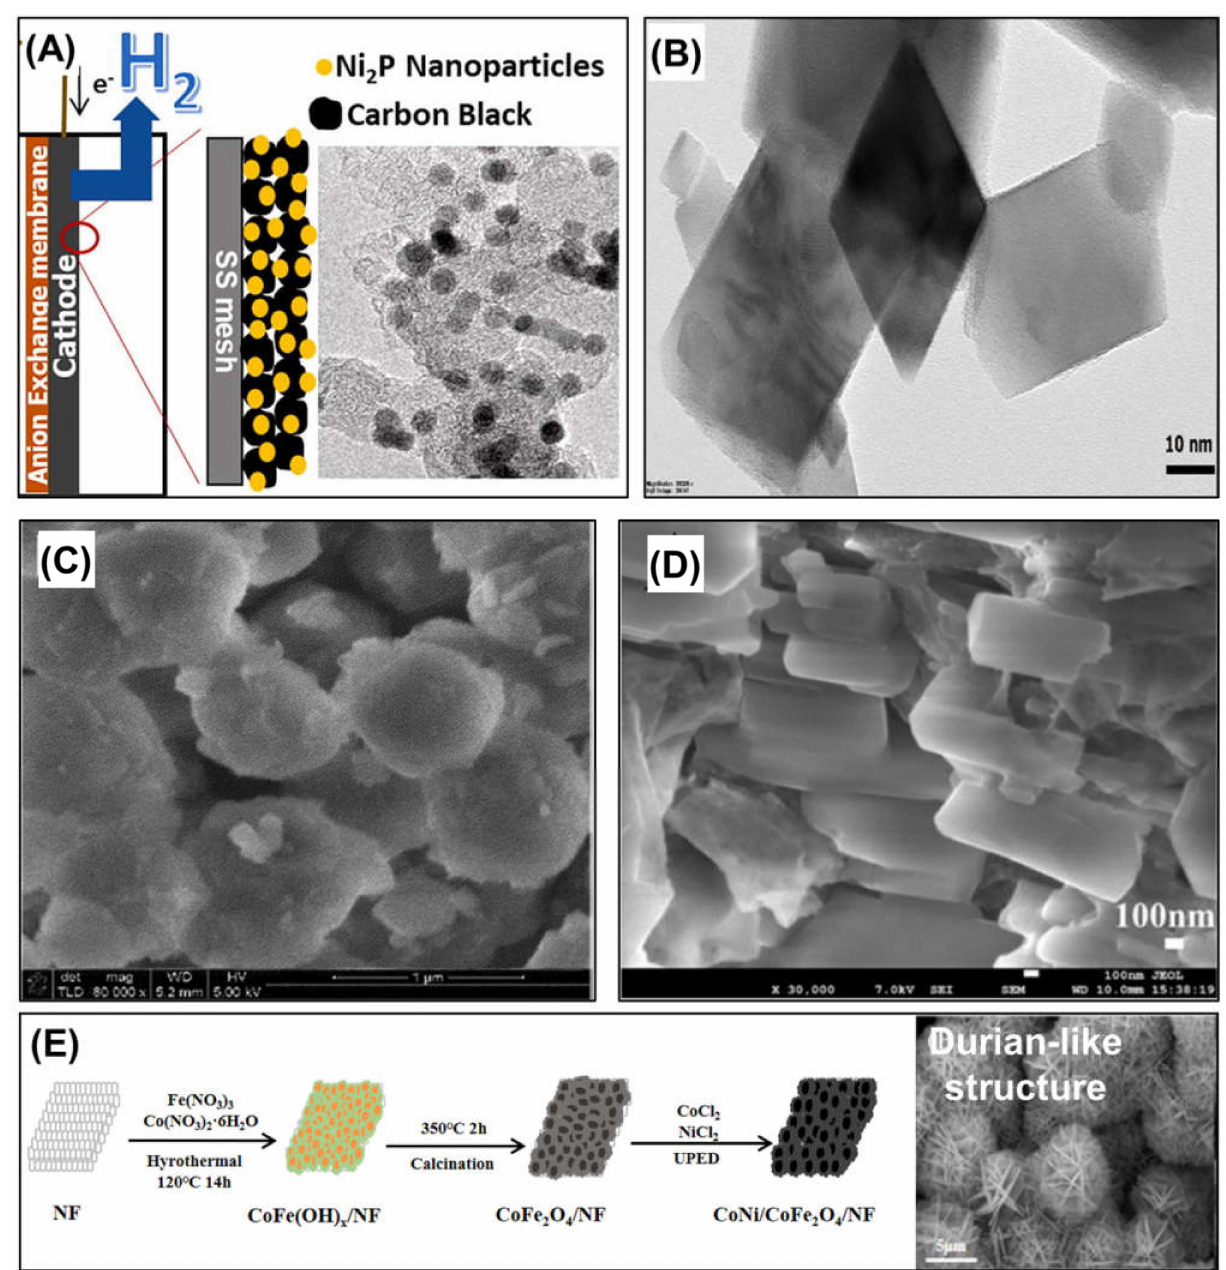
Figure 6. Metal compound-based nanomaterials employed as cathodic catalysts for hydrogen pro- duction: ( A ) Ni 2 P NPs on carbon black used as cathodic catalyst. Reprinted with permission from Ref. [42]. Copyright Elsevier 2019, ( B ) NiMoO 4 NP catalysts for modifying a Ni foam cathodic elec- trode in an MEC. Reprinted with permission from Ref. [34] Copyright Elsevier 2020, ( C ) NiO-loaded Y zeolite nanocomposites. Reprinted with permission from Ref. [58]. Copyright Taylor & Francis 2019, ( D ) NiO/MoO 2 /MoO 3 /C nanocomposites. Reprinted with permission from Ref. [32] Copyright ESG 2019, and ( E ) synthesis procedure of CoNi/CoFe 2 O 4 composite and a microscopic image of CoNi/CoFe 2 O 4 composites with durian-like structure. Reprinted with permission from Ref. [33]. Copyright Wiley